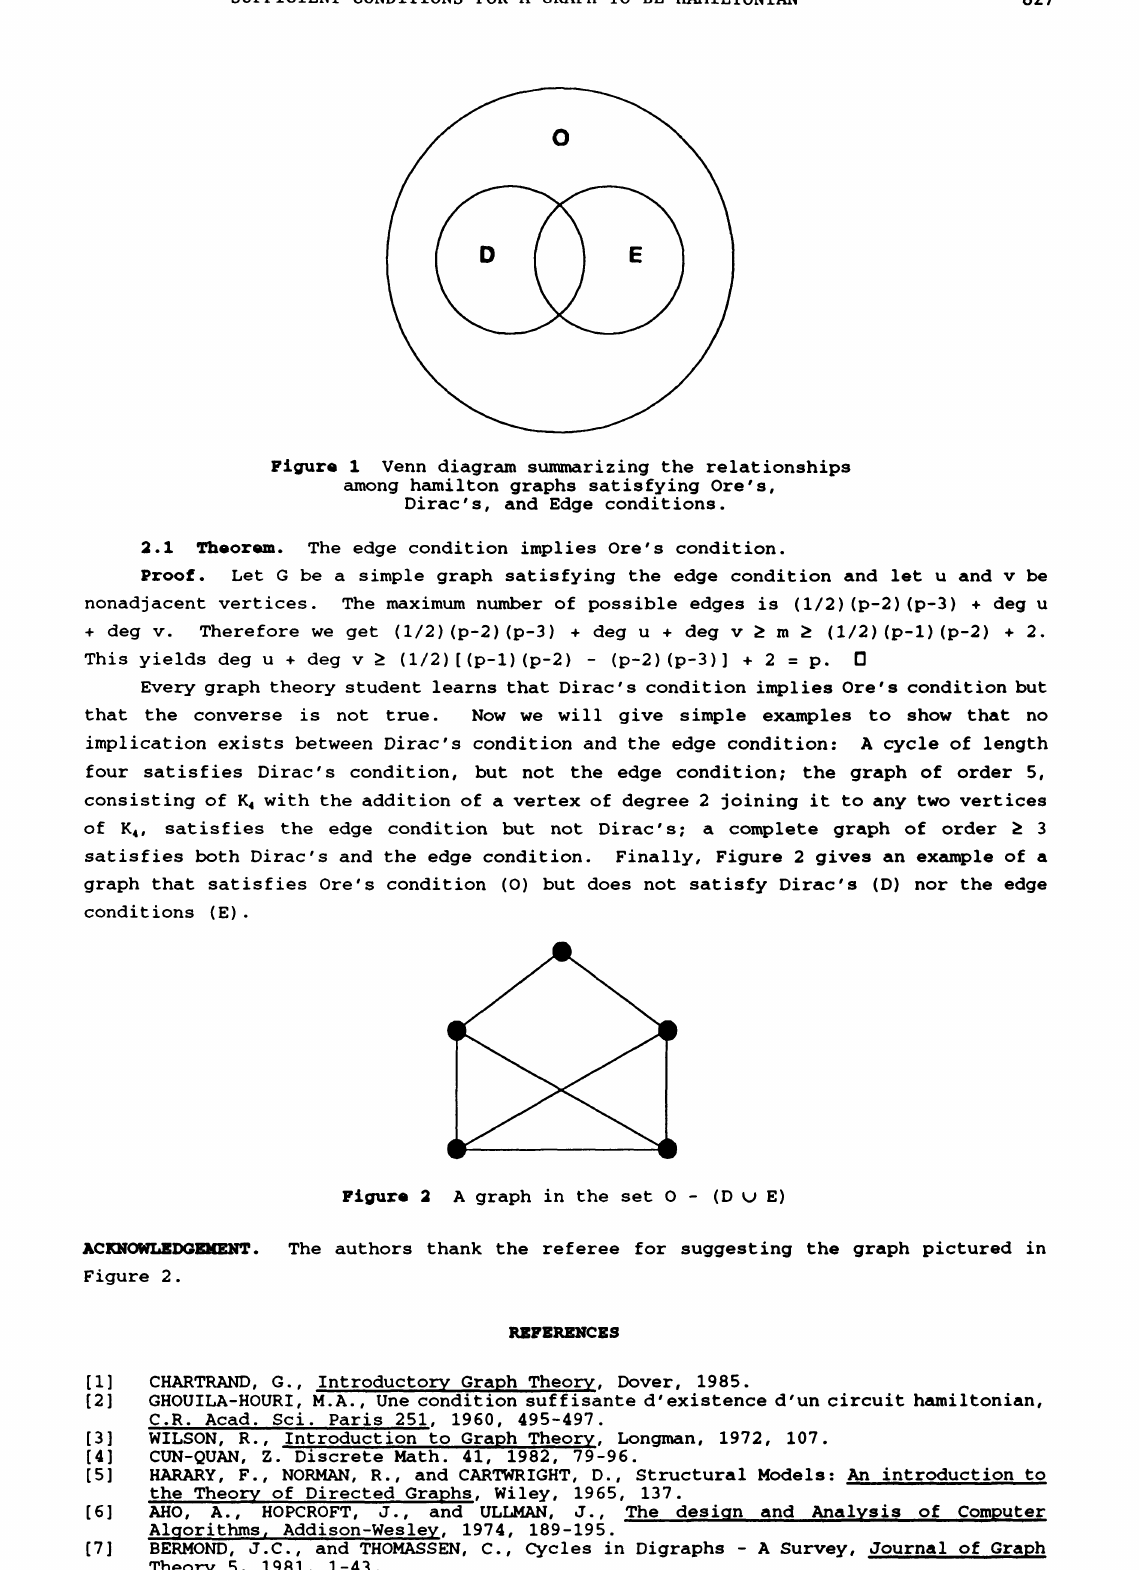
Figure 2 A graph in the set O (D